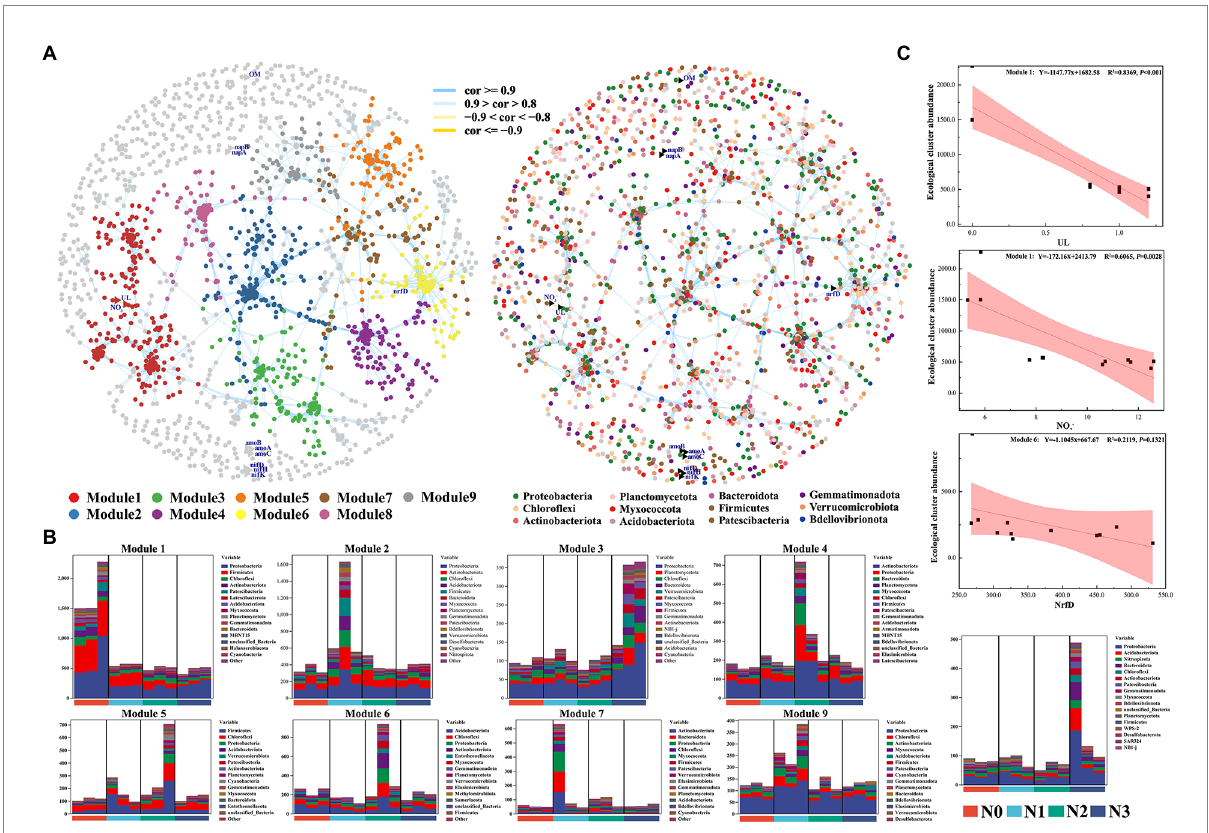
FIGURE 6 Response of co-occurrence networks of soil microbial communities to experimental N